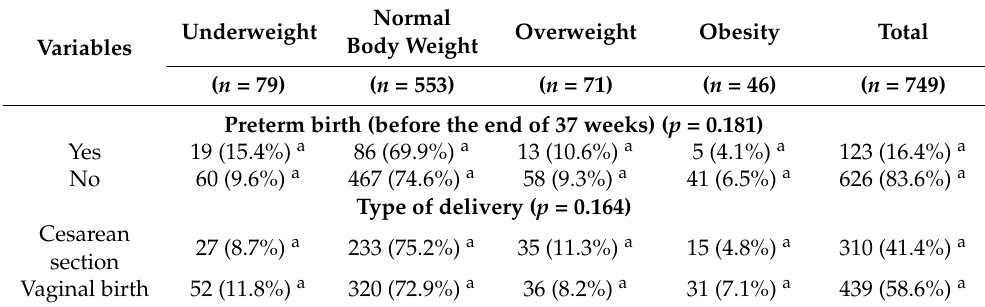
Table 3. Body mass category according to the BMI centile, depending on the type of delivery and preterm